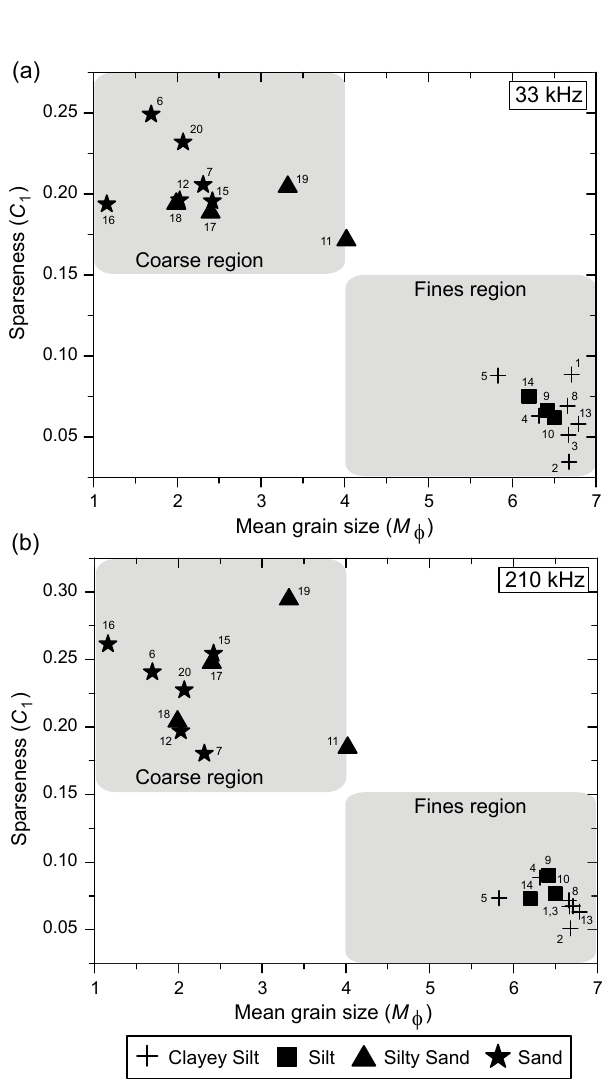
Fig. 5. Frequency-wise scatter plot of the measured M ϕ and com- puted codimension parameter C 1 at 33 and 210 kHz. The shaded region demarcates the boundaries of C 1 in coarse and fine sediment